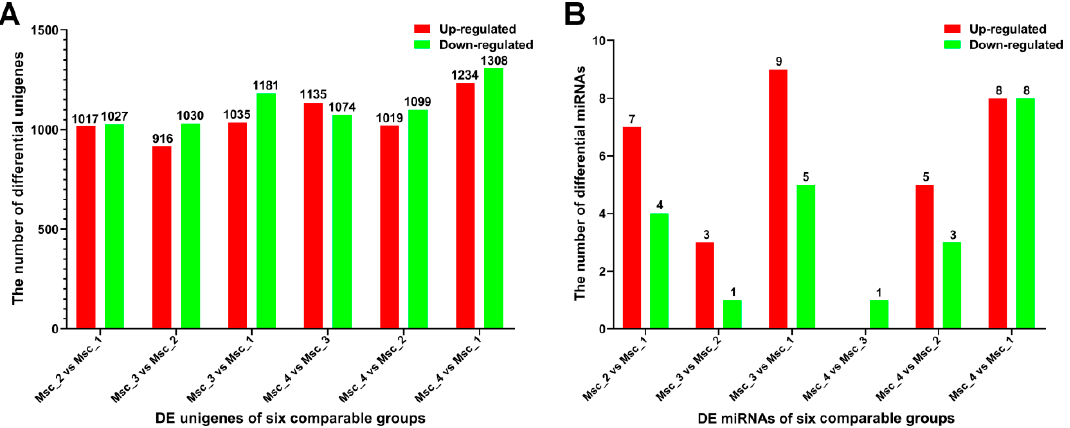
Figure 1. Statistics for DE unigenes and miRNAs in each comparable group. ( A ) Statistics of DE unigenes. ( B ) Statistics of DE miRNAs. q value < 0.005 and | log2(fold change) |> 1 were used as thresholds of significance for DE unigenes. q value < 0.01 and | log2 (fold change) |> 1 were used as thresholds of significance for DE miRNAs.